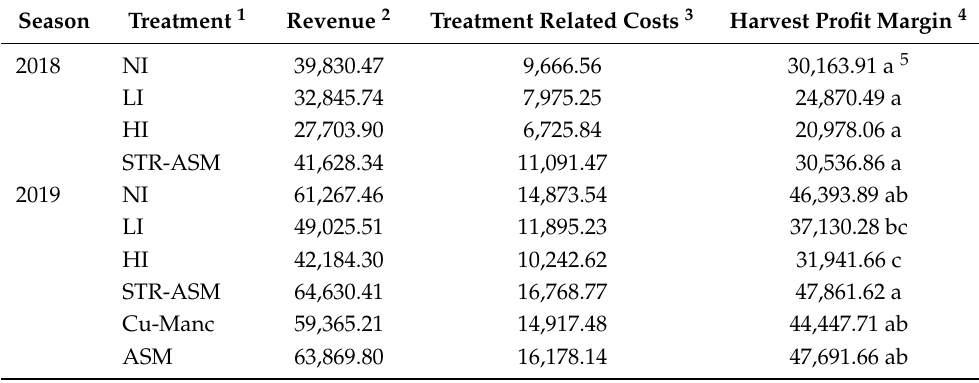
Table 4. Costs and revenues summary by season and treatment represented in